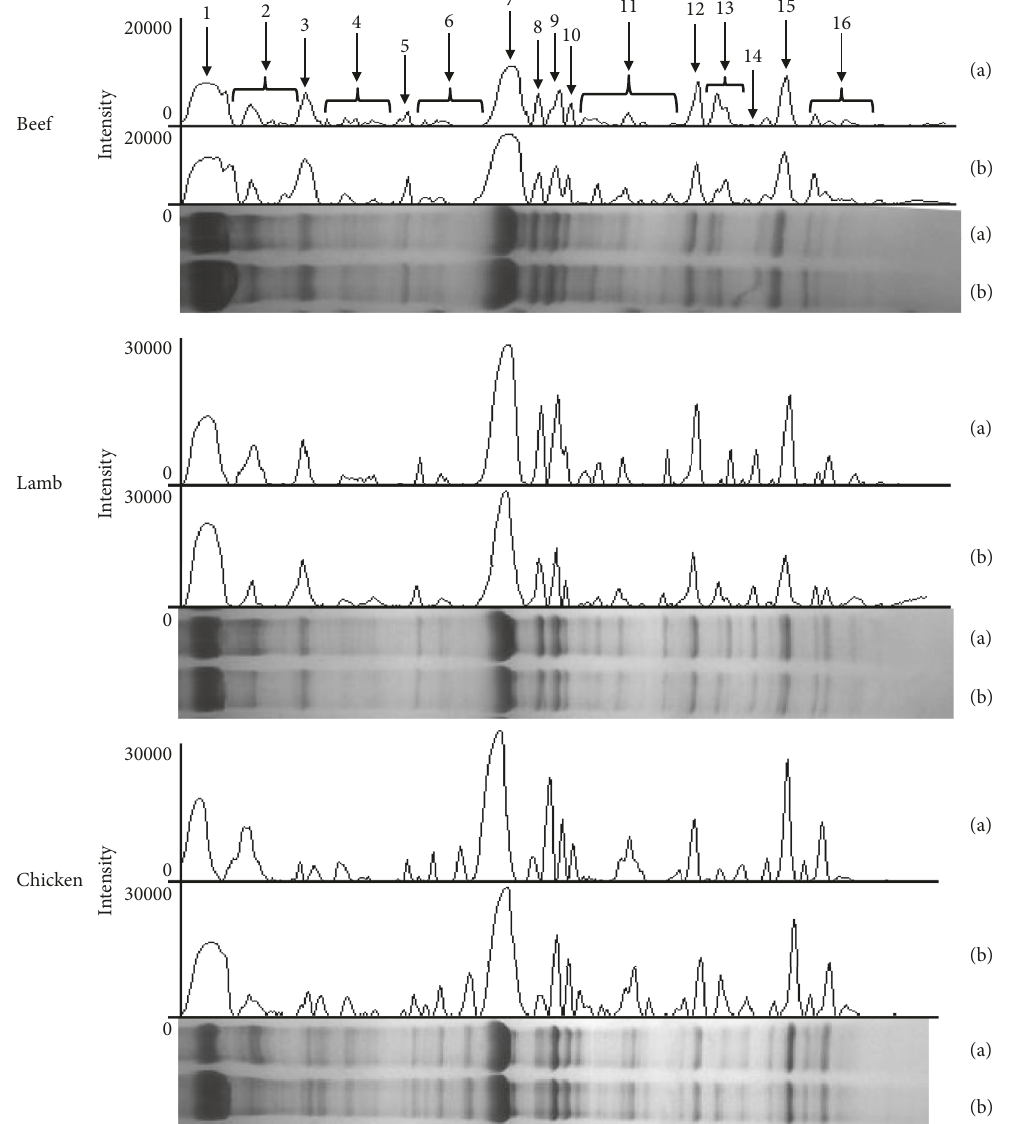
Figure 3: Densitometric profile and SDS-PAGE of a pool of 15 myofibrillar extracts obtained from beef, lamb, and chicken samples extracted with denaturing (a) and nondenaturing (b) solutions (1 � myosin heavy chain; 2 � 180–110 kDa; 3 � α -actinin; 4 � 95–55kDa; 5 � desmin; 6 � 51–47 kDa; 7 � actin; 8 � 39kDa; 9 � troponin T; 10 � tropomyosin; 11 � 33–23 kDa; 12 � myosin light chain 1; 13 � 21–18kDa; 14 � troponin C; 15 � myosin light chain 2; 16 � 14–10